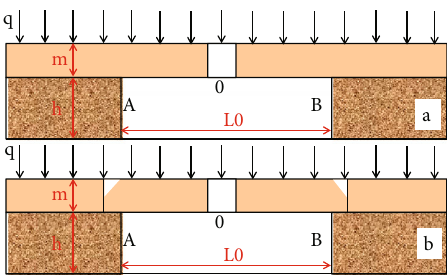
Figure 3: The model of embedded solid beams and the model of charpy